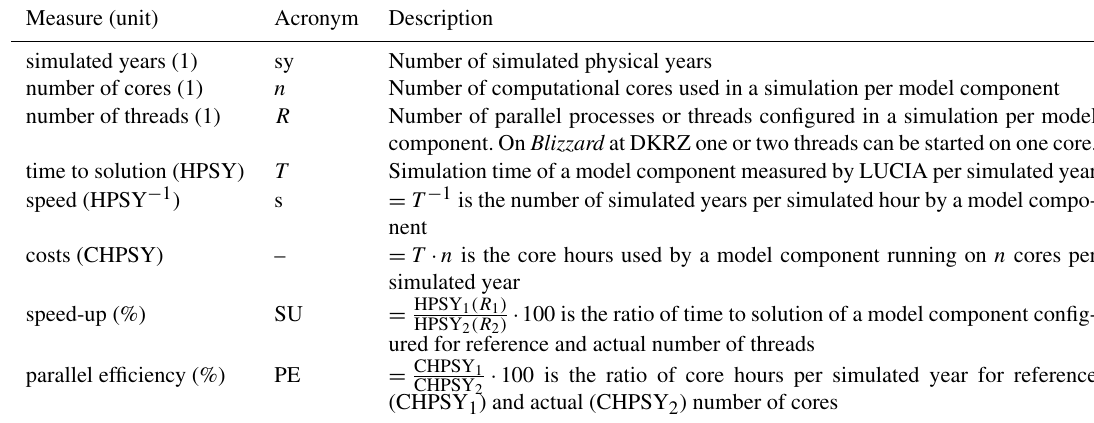
⊗ – – ⊗ (cid:26) (cid:26) Surface downward latent heat flux (Wm − 2 ) – (cid:26) Surface direct and diffuse downwelling short-wave flux in air (Wm − 2 ) ⊗ ⊗ ⊗ – (cid:26) (cid:26)